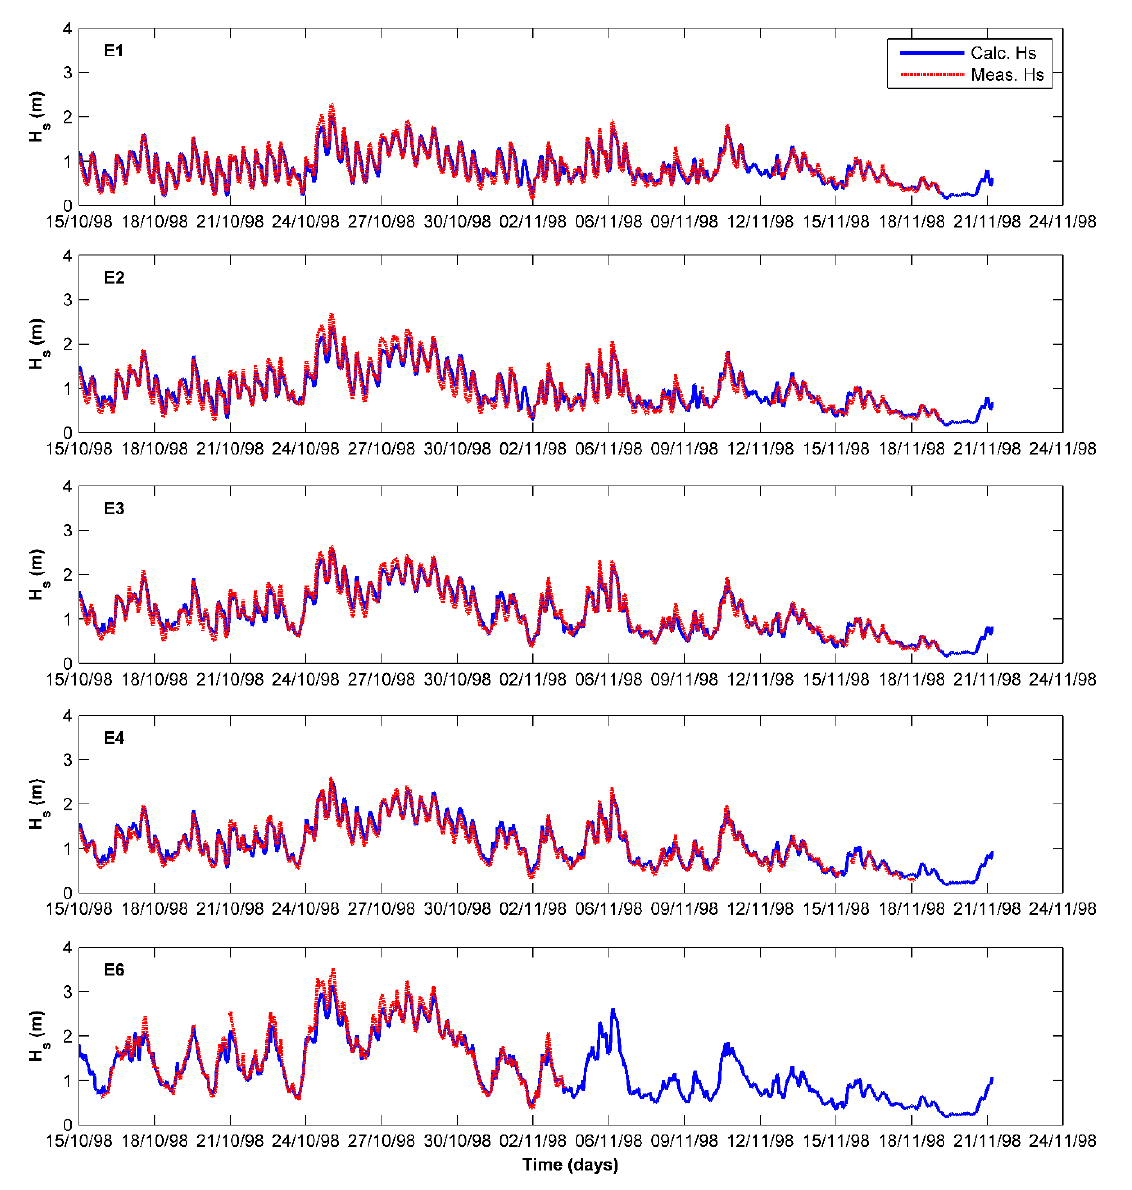
Figure 6. Calculated significant wave height and measurements at Egmond Beach.